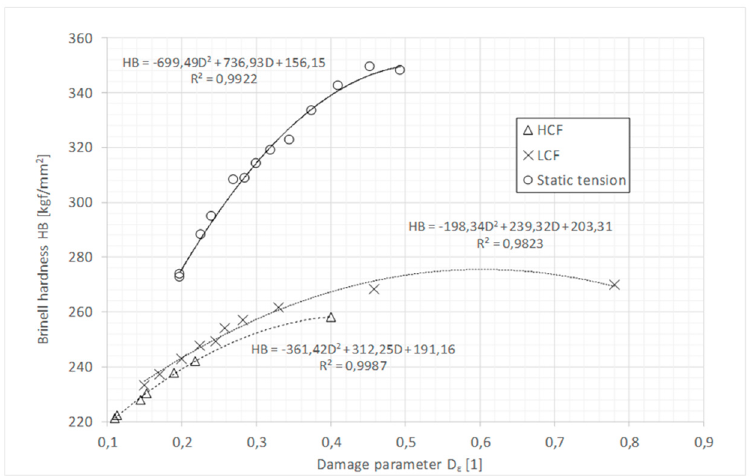
Figure 8. Hardness as the function of reference damage parameter for all applied loading regimes.